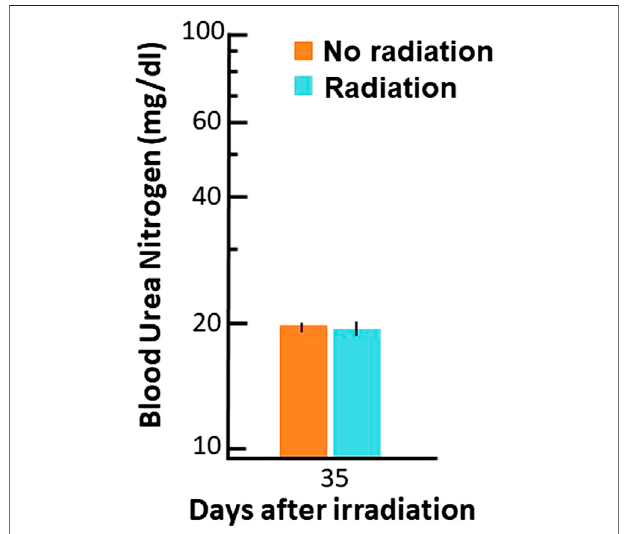
FIGURE 7 | Blood urea nitrogen (BUN, mg/dl (log scale on Y -axis)) values at 35 days after radiation. Data are shown as means and 95% con fi dence